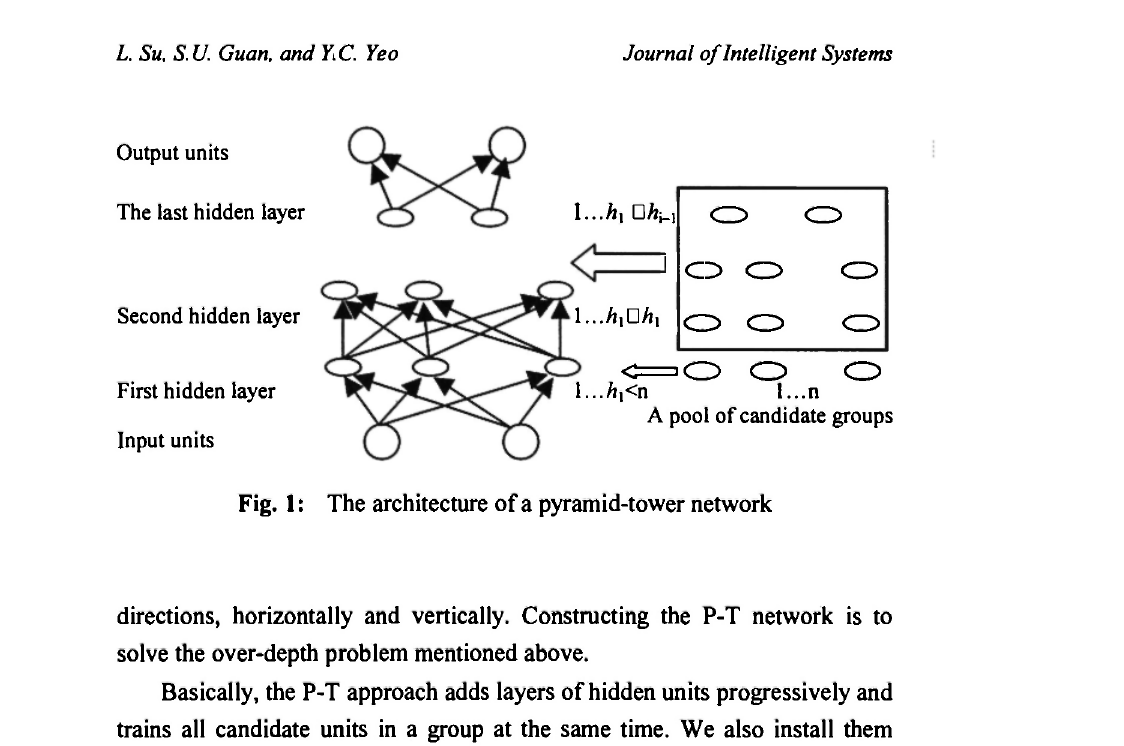
Fig. 1: The architecture of a pyramid-tower